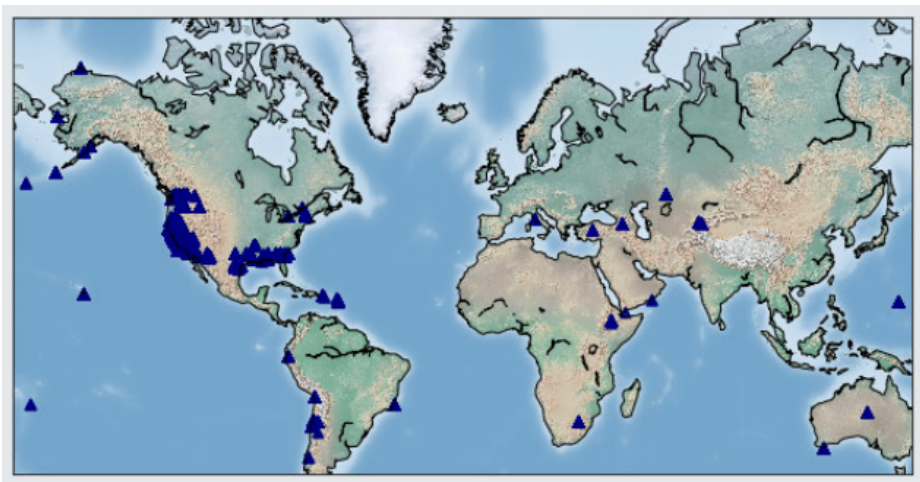
Figure 2. A distribution map of the stations (the dark blue triangles show the locations of the stations that recorded the seismic noise).